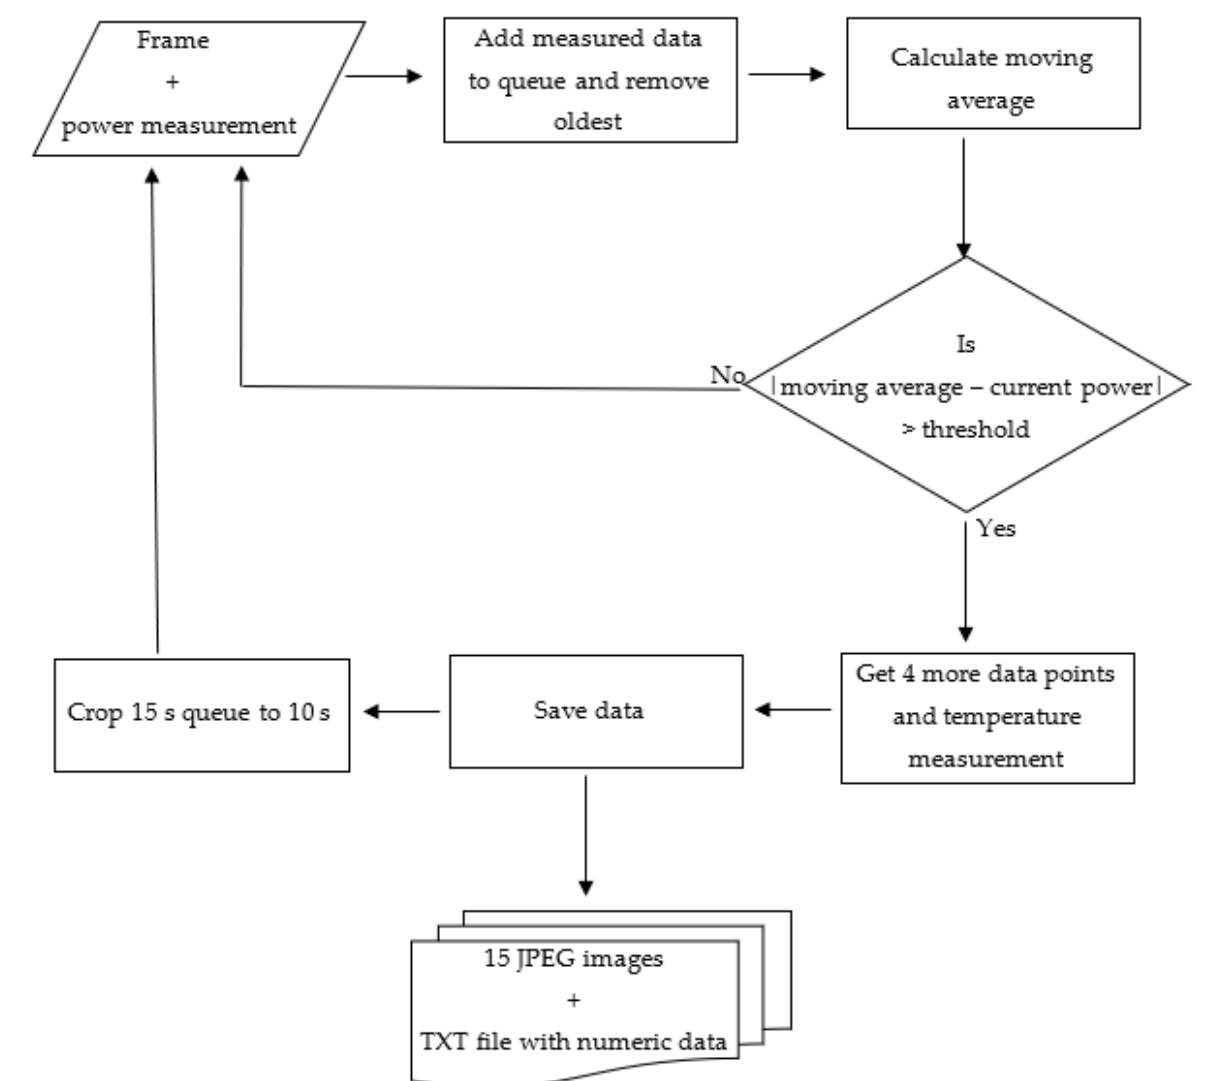
Figure 4. Flowchart of decision process and data flow within DAS software. The first column contains the time stamps from each measurement point in the